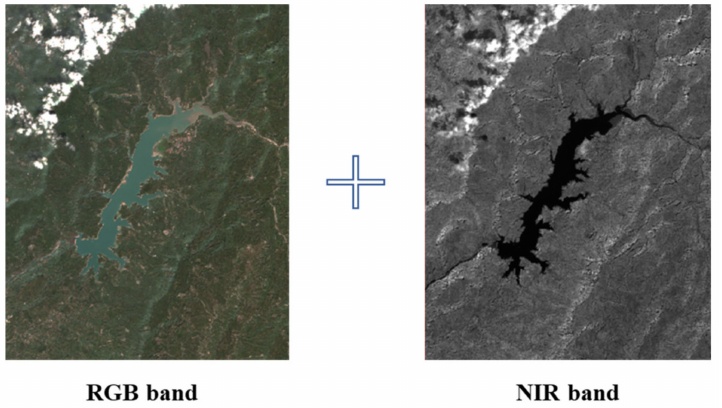
Figure 2. The data format of Sentinel-2 Level-2A product used to construct our dataset.